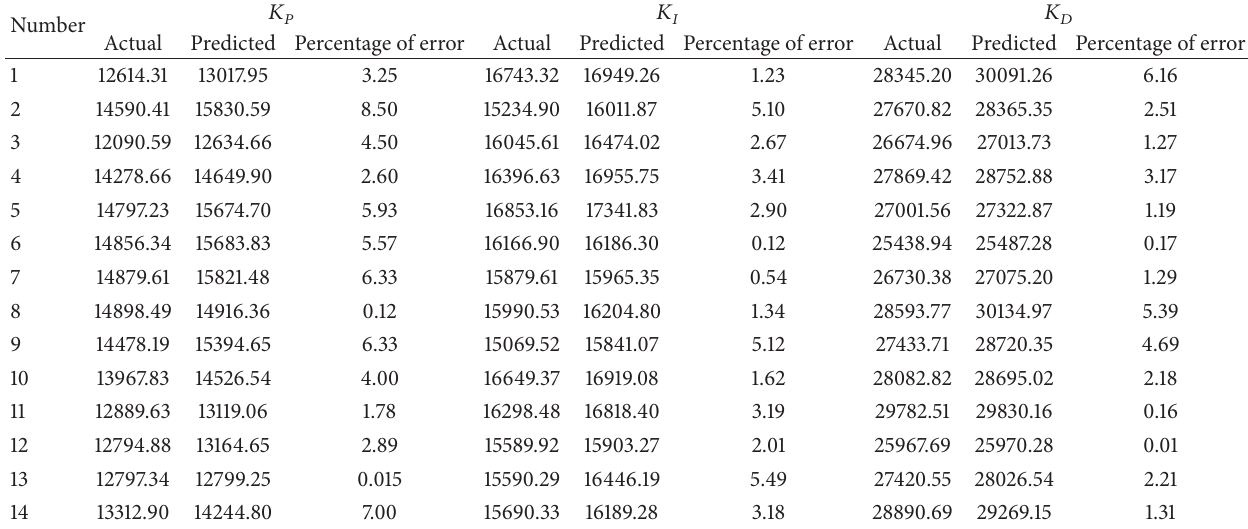
Table 9: Comparison between actual gain parameters of PID and the BPN model (with newelm function).